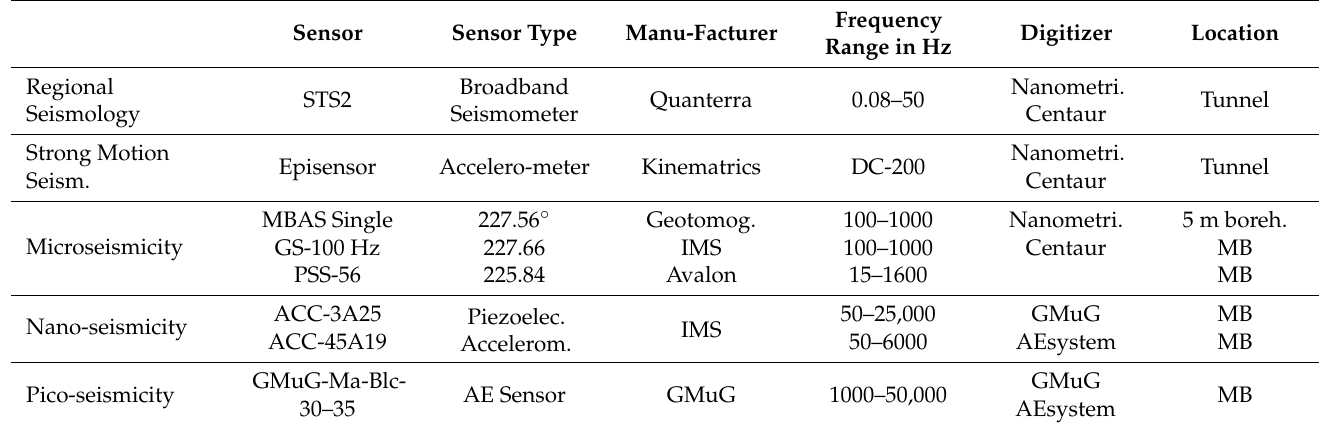
Table 4. Overview of seismic